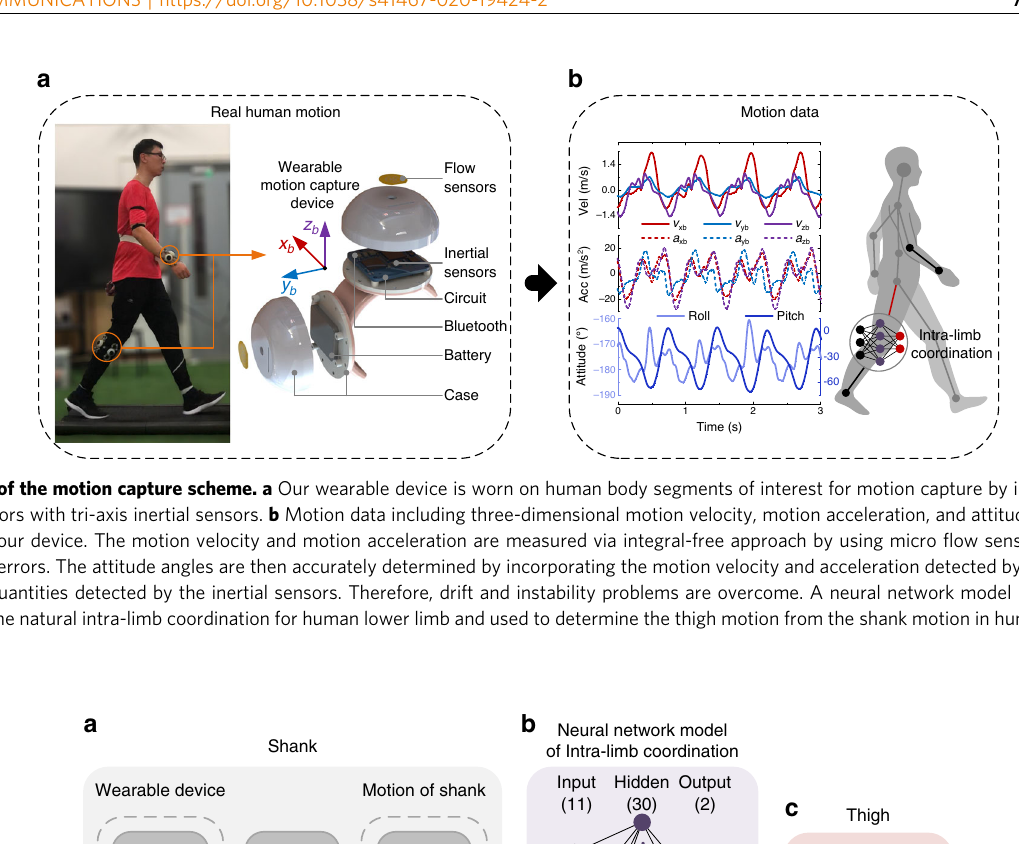
the velocity sensor based on fl ow detection. The tri-axis motion acceleration a b is estimated from Eq. (1) by linear algebraic gyroscope (shown in Fig. 1b). Here, subscript b refers to the body